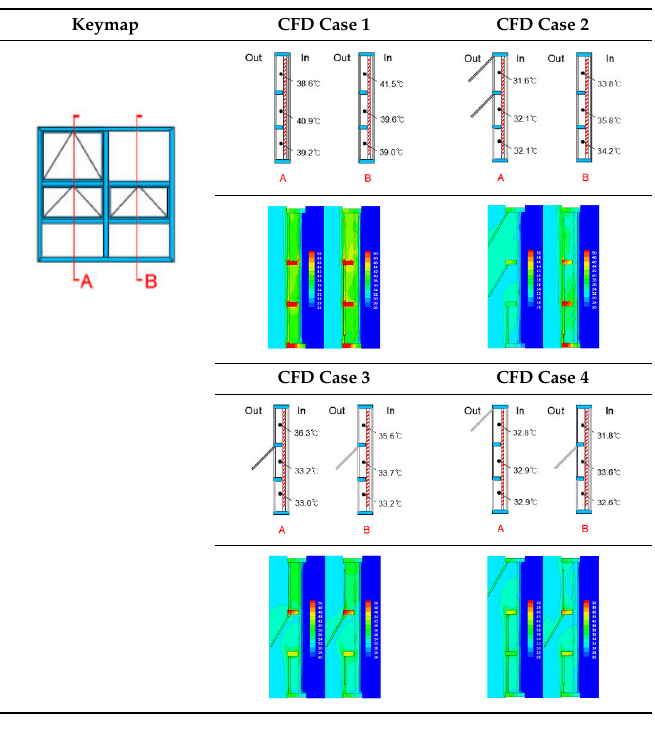
Table 15. Temperature distributions of CFD